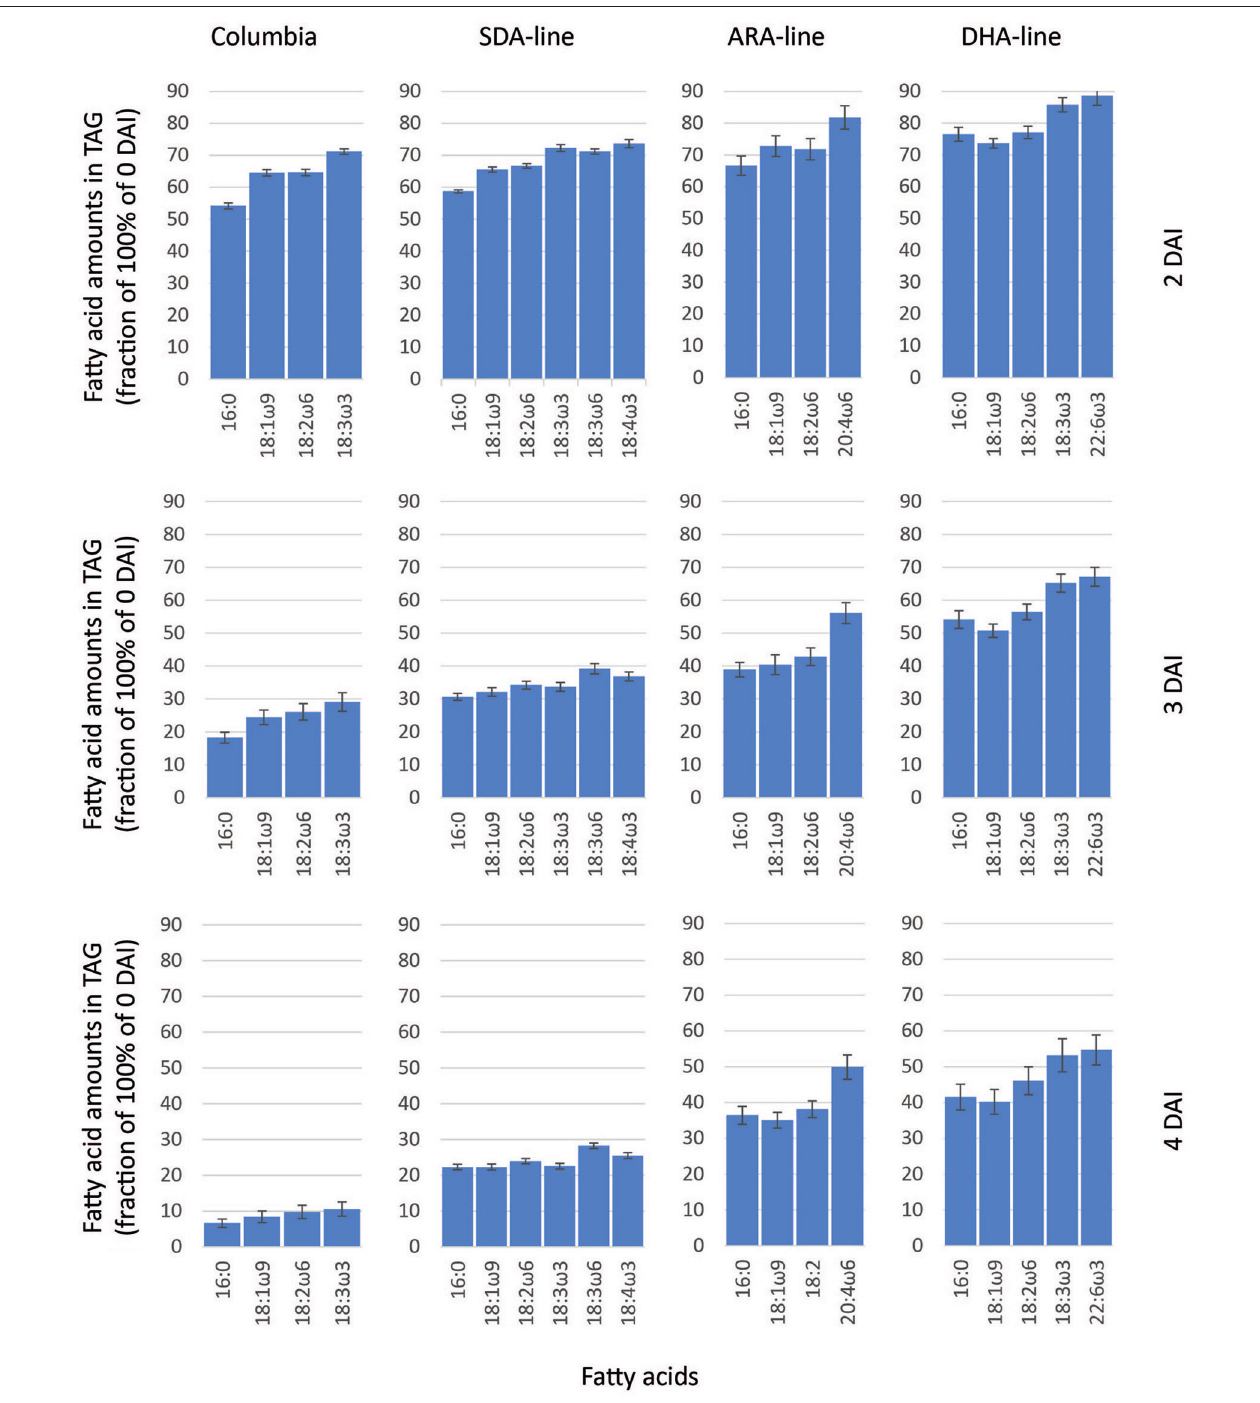
experiments with detailed TAG species analysis from 0 to 4 DAI by LC-MS, especially there was very low levels of ALA due to the